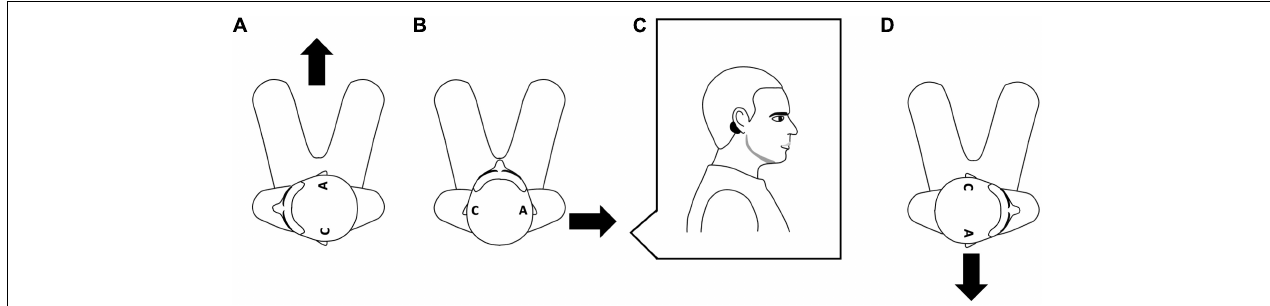
FIGURE 1 | Relationship between head rotation, electrodes position and usual direction of the induced body sway. The figure presents an aerial view of the seated participant. The letter “C” indicates the position of the cathode and the letter “A” indicates the position of the anode, and the black arrows indicate the direction of the induced body sway. Left head rotation with the anode on the right mastoid induces a forward sway (A) , no head rotation with the anode on the right mastoid usually induces a right body sway (B) and right head rotation with the anode of the right mastoid induces a backward sway (D) . (C) Depicts a side view of the participant to show the position of an electrode (black circle) on the mastoid